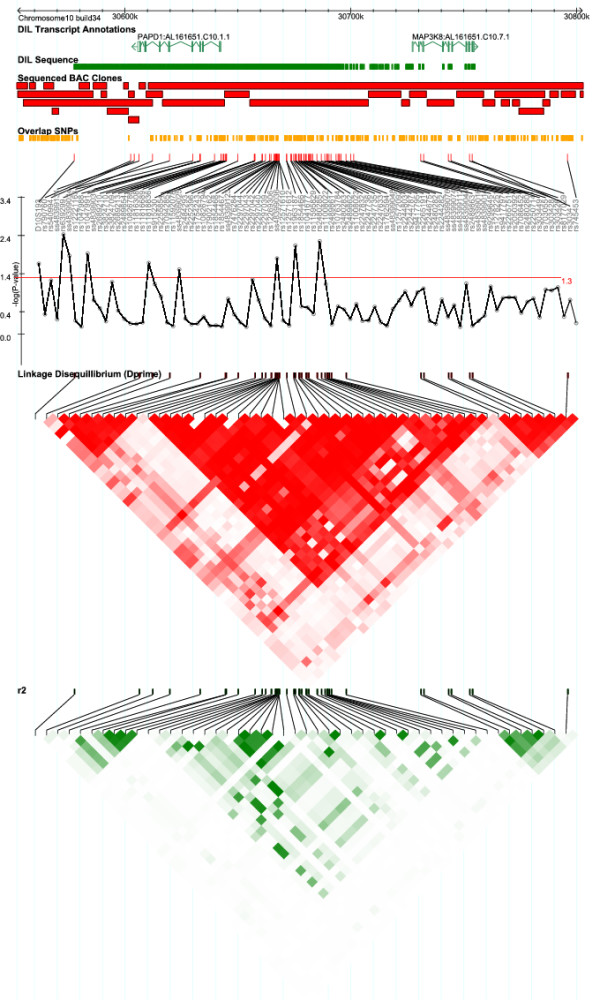
The PAPD1-MAP3K8 gene region on chromosome 10. Tracks indicate (from top to bottom): position in the human genome chromosome 10, NCBI build 34; annotated genes; regions where resequencing of the amplified fragments has been attempted; sequenced BAC clones; SNPs identified in the clone overlaps; polymorphisms genotyped in up to 765 UK and USA families with two affected offspring; SNP rs or ss numbers; a plot showing -log(P-value) for association in up to 765 families with red line at 1.3 corresponding to P = 0.05; linkage disequilibrium (LD) plots for SNPs with minor allele frequency > 0.1 showing pairwise LD by colour ranging from red (high D') or dark green (high r2), indicating strong LD, to white, indicating weak or no LD between SNPs. LD plots have been generated using Haploview [27].